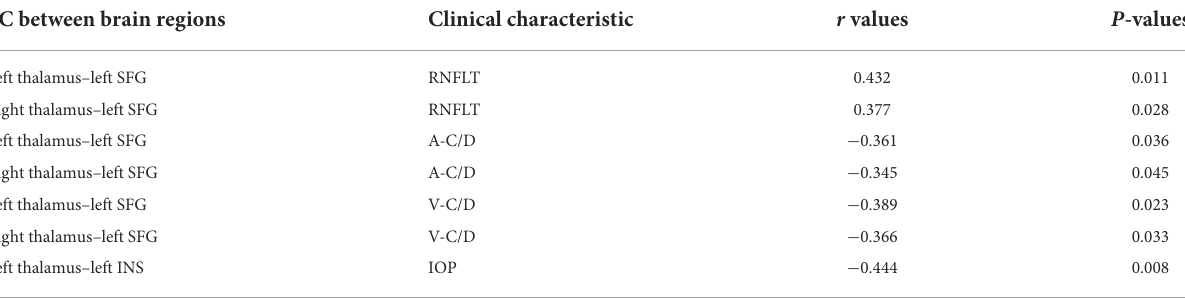
TABLE 3 Significant associations between thalamic FC and clinical characteristics in PACG patients. FC between brain regions Clinical characteristic r values P